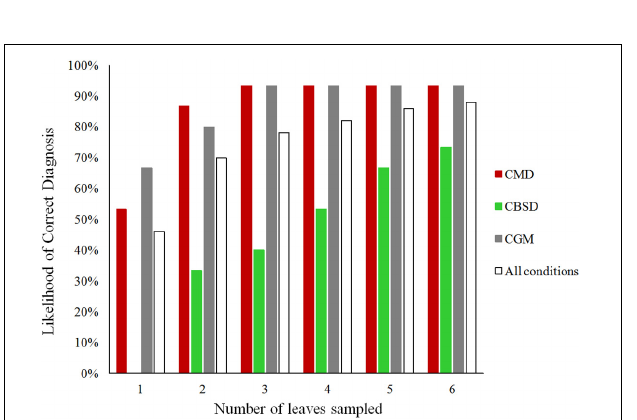
FIGURE 2 | The likelihood of obtaining a correct diagnosis for CMD, CBSD, CGM-damage, and all the three conditions from cassava leaves obtained from 90 plants by using the PlantVillage Nuru app for symptoms based on the number of leaves sampled.